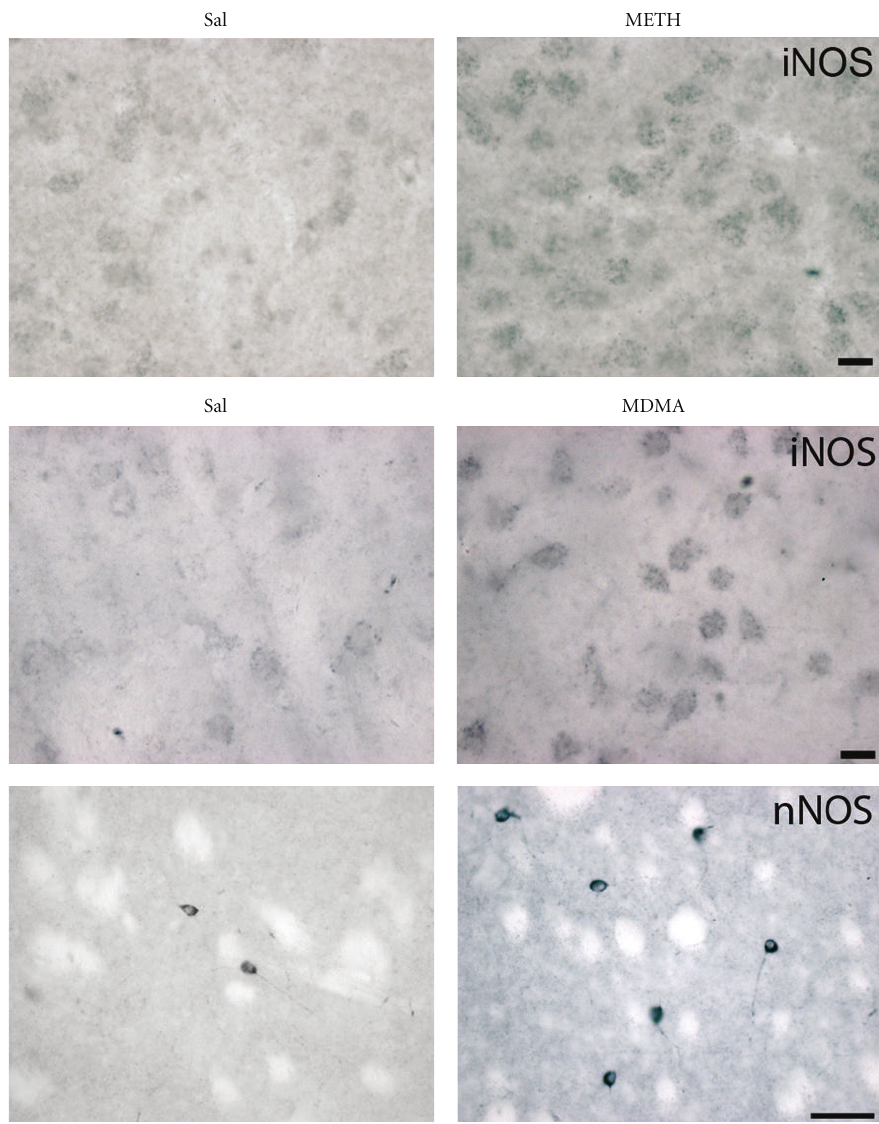
Figure 3: Methamphetamine and MDMA increase the expression of inducible nitric oxide synthase (iNOS) and neuronal nitric oxide synthase (nNOS) in mouse striatum. Photomicrographs of striatal sections of mice treated with saline or methamphetamine (5 mg/kg × 3) or MDMA (20mg/kg × 3) stained for iNOS and nNOS. Animals were killed 1 day after treatment. Bar indicates 10 𝜇 m for iNOS and 50 𝜇 m for nNOS. Modified from Granado et al.